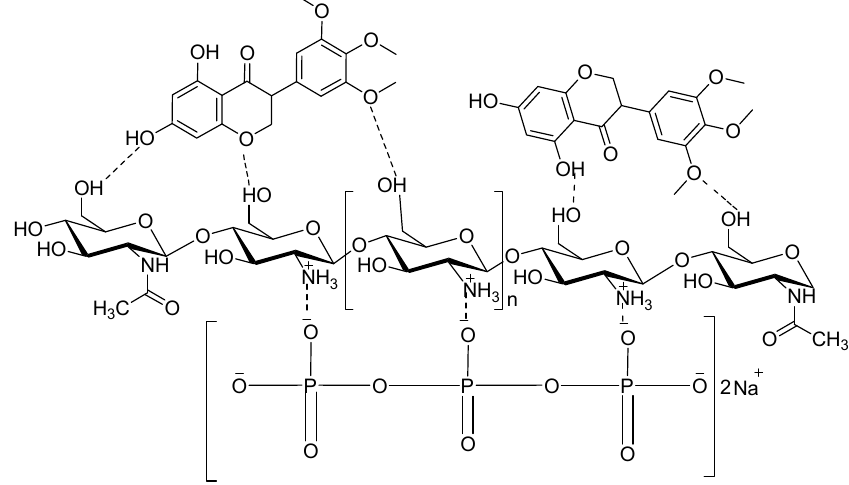
Figure 5. Hypothetical interactions between of CS/TPP and PANV.